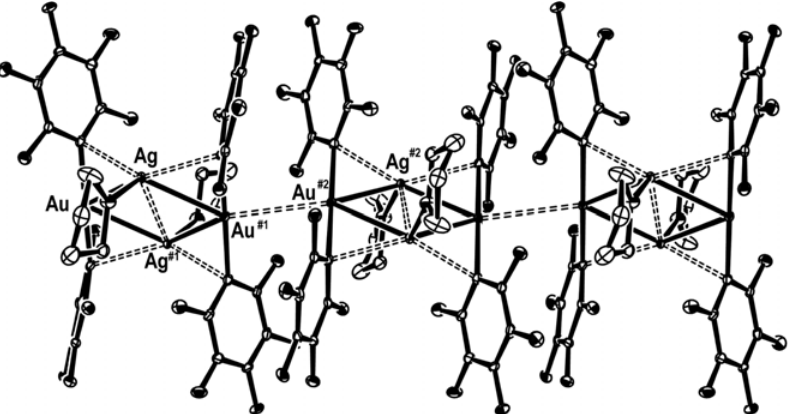
Figure 5. A portion of the polymeric structure of {Ag atoms have been omitted for clarity. Reproduced with permission from